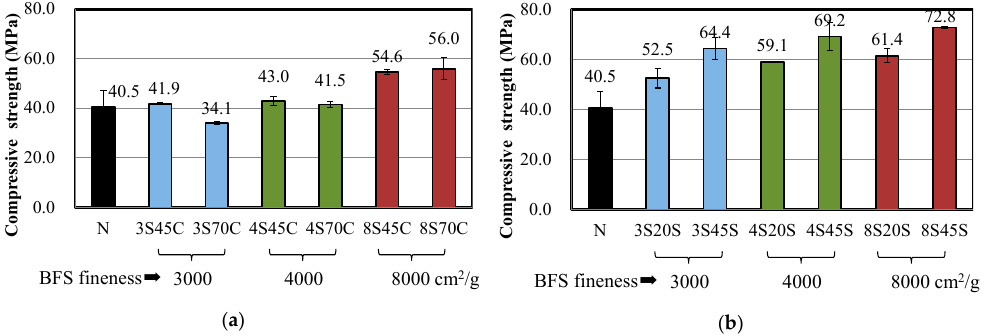
Figure 2. Compressive strengths of mixtures made with different BFS replacement ratios: ( a ) BFS as a replacement for cement and ( b ) BFS as a replacement for sand.